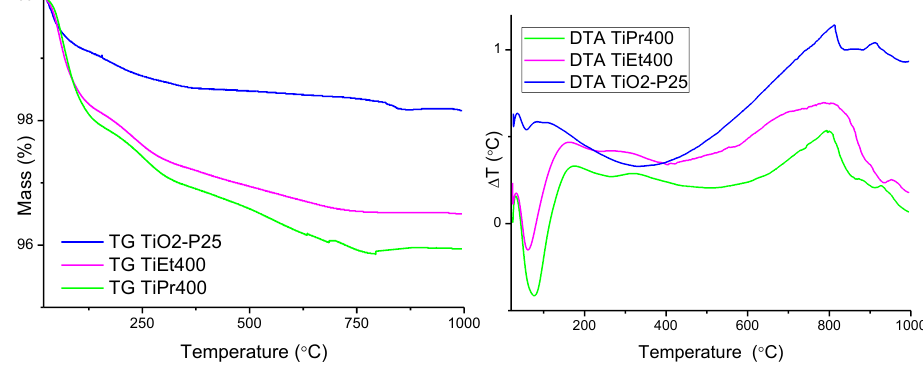
Figure 5. TG and DTA curves of TiEt400, TiPr400 and TiO 2 −P25